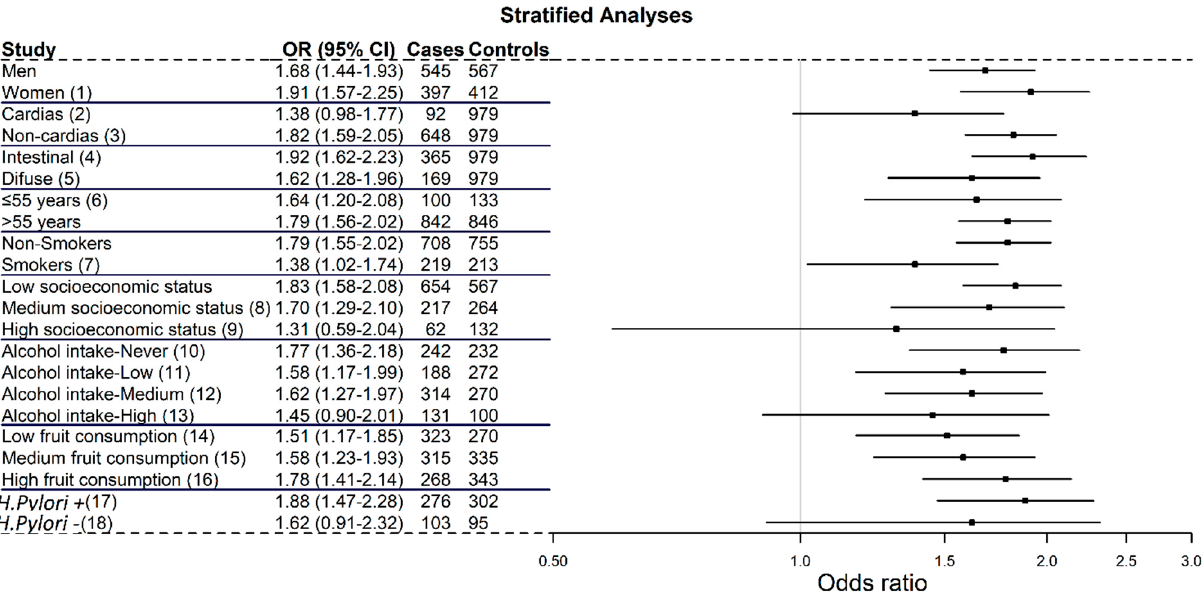
Figure 3. Pooled adjusted odds ratios with 95% confidence intervals for gastric cancer associated with a family history of gastric cancer stratified by sex, age, socioeconomic status, gastric cancer location, histological subtype, tobacco smoking, alcohol intake, fruit consumption and Helicobacter pylori infection in the StoP Project. No information for studies: (1) De Feo, Lagiou; (2) Foschi, Lagiou, Mu, Setiawan; (3) Mu, Setiawan; (4) La Vecchia, Lagiou, Mu, Setiawan, Machida-Montani;